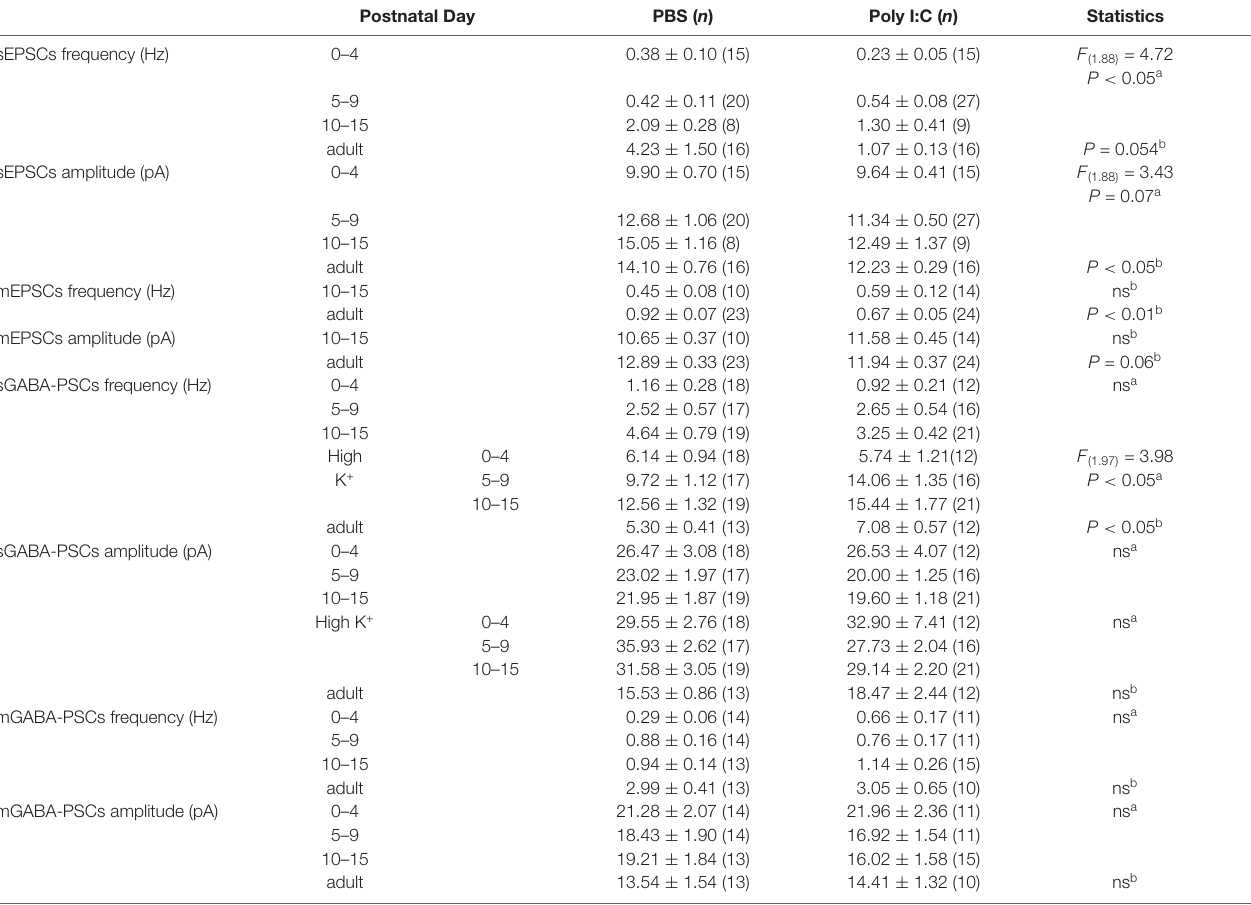
TABLE 2 | Summarized data of comparisons between offspring from PBS-treated and poly I:C-treated dams. Postnatal